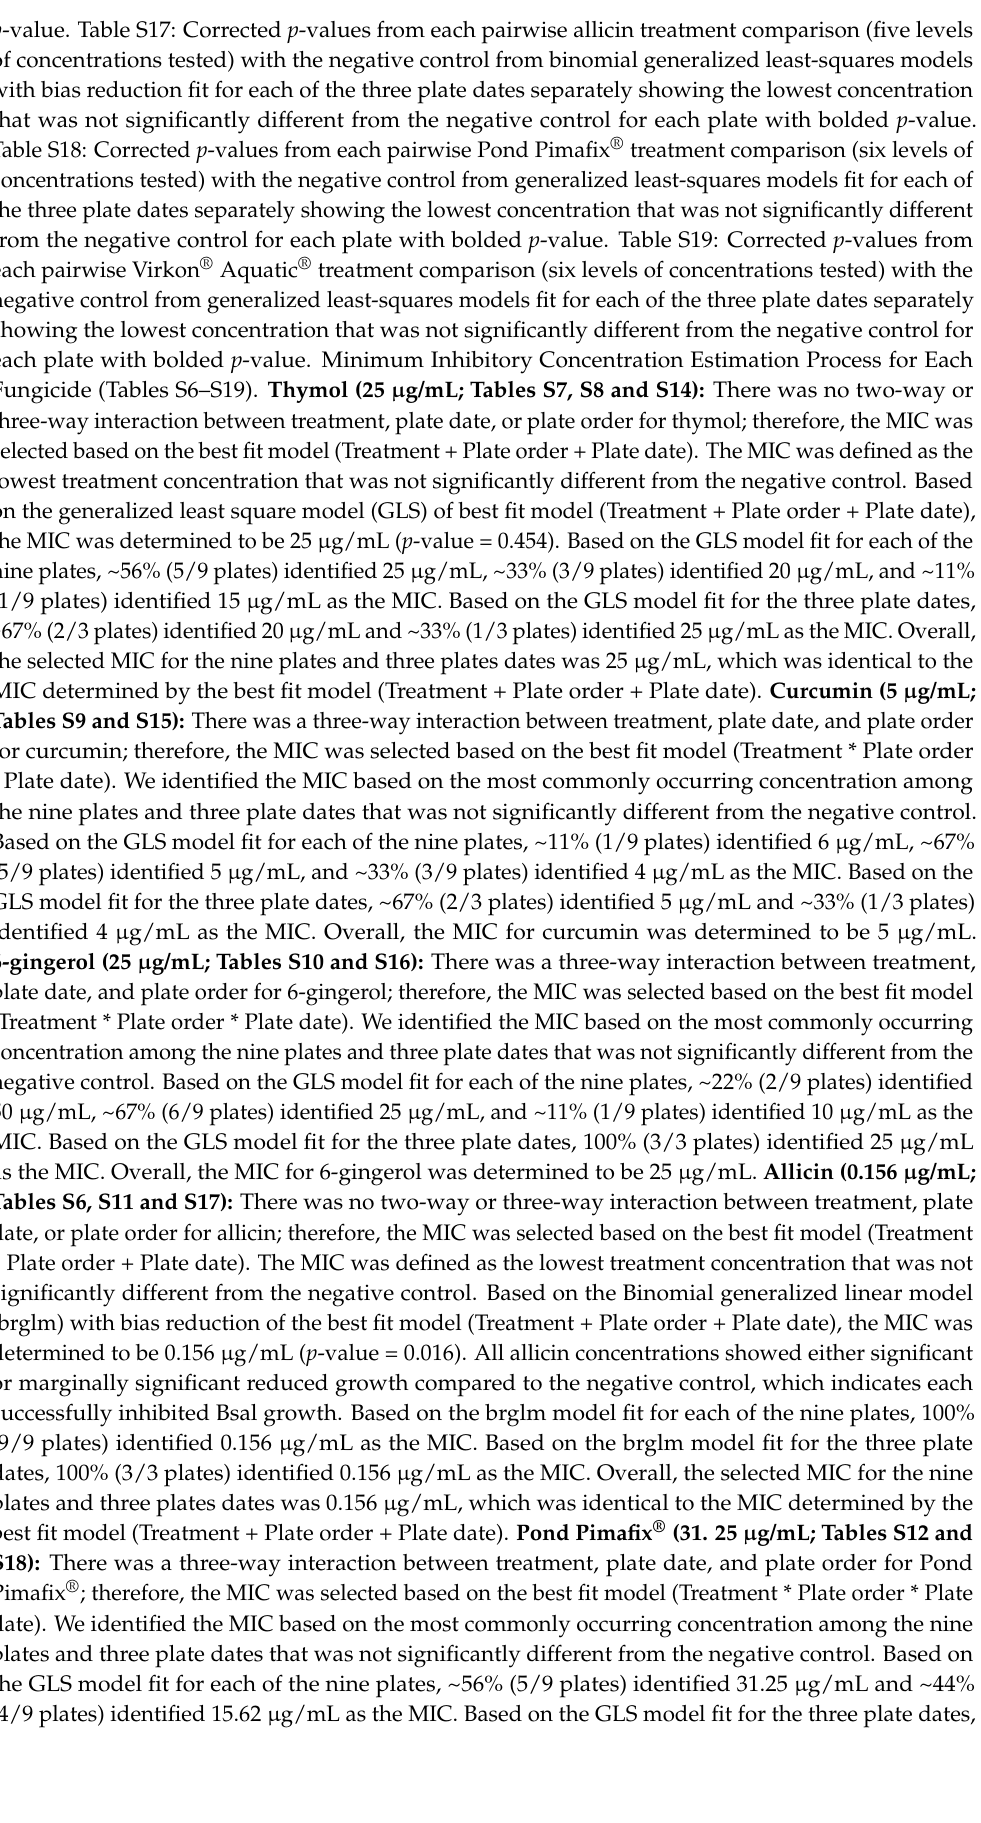
p -value. Table S17: Corrected p -values from each pairwise allicin treatment comparison (five levels of concentrations tested) with the negative control from binomial generalized least-squares models with bias reduction fit for each of the three plate dates separately showing the lowest concentration that was not significantly different from the negative control for each plate with bolded p -value. Table S18: Corrected p -values from each pairwise Pond Pimafix ® treatment comparison (six levels of concentrations tested) with the negative control from generalized least-squares models fit for each of the three plate dates separately showing the lowest concentration that was not significantly different from the negative control for each plate with bolded p -value. Table S19: Corrected p -values from each pairwise Virkon ® Aquatic ® treatment comparison (six levels of concentrations tested) with the negative control from generalized least-squares models fit for each of the three plate dates separately showing the lowest concentration that was not significantly different from the negative control for each plate with bolded p -value. Minimum Inhibitory Concentration Estimation Process for Each Fungicide (Tables S6–S19). Thymol (25 µ g/mL; Tables S7, S8 and S14): There was no two-way or three-way interaction between treatment, plate date, or plate order for thymol; therefore, the MIC was selected based on the best fit model (Treatment + Plate order + Plate date). The MIC was defined as the lowest treatment concentration that was not significantly different from the negative control.